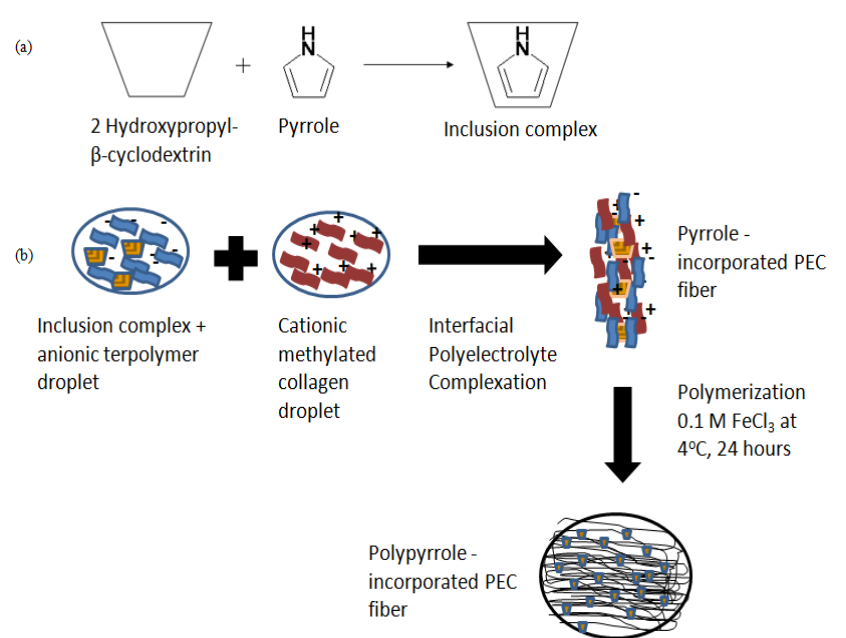
Figure 1. ( a ) 2-Hydroxypropyl-  -cyclodextrin-pyrrole inclusion complex. ( b )